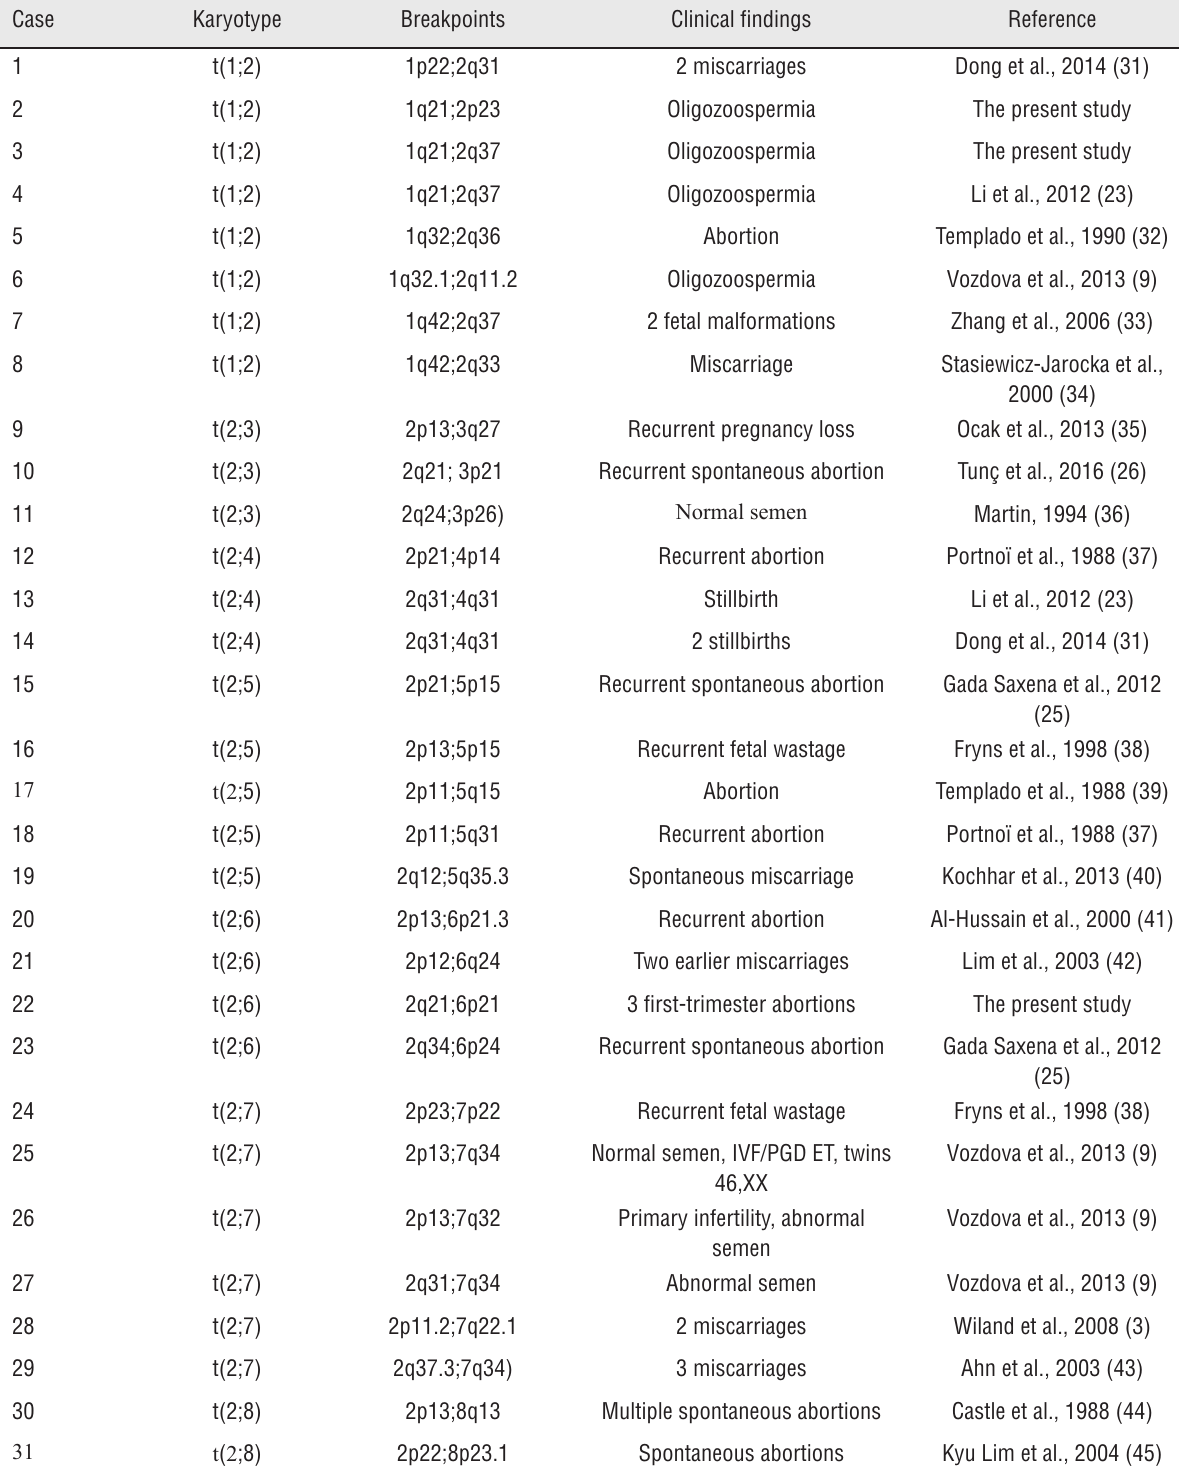
Table 2 - Breakpoints in chromosome 2 translocation carriers and clinical